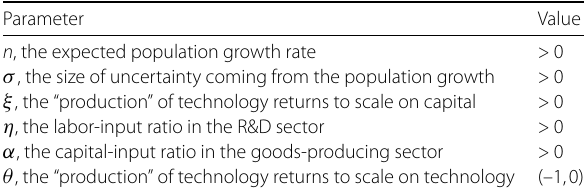
Table 1 Parameter values for R&D model (2) Parameter Value n , the expected population growth